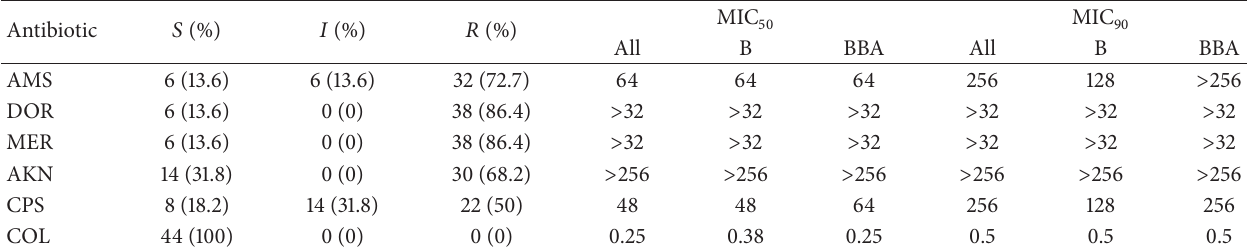
Table 3: MIC ( 𝜇 g/mL) for 44 ACB complex isolates recovered from 38 ICU patients.